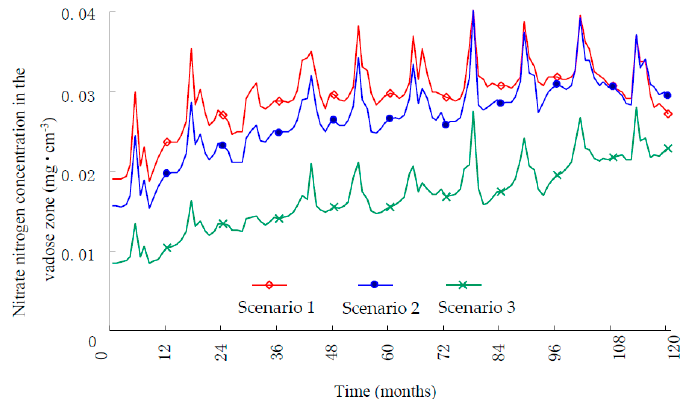
Figure 9. The nitrate nitrogen concentrations at different depths in the vadose zone over time.